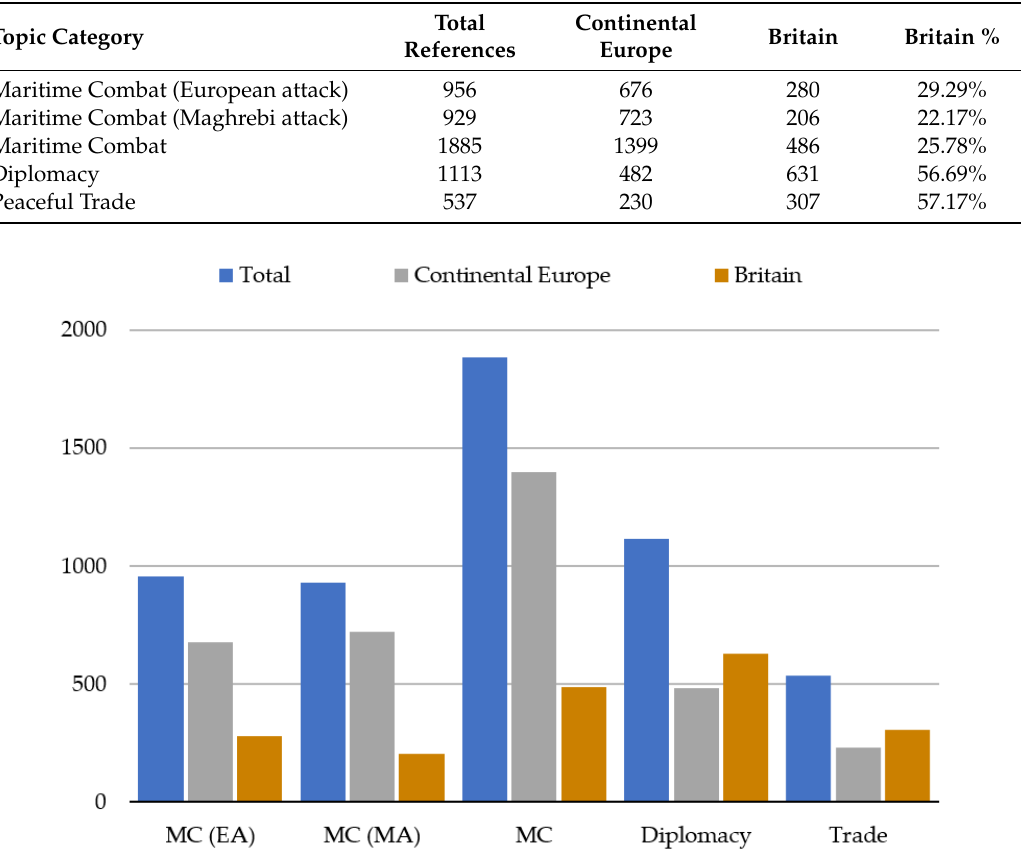
Table 2. References to maritime combat, diplomacy and trade (British and European relations).